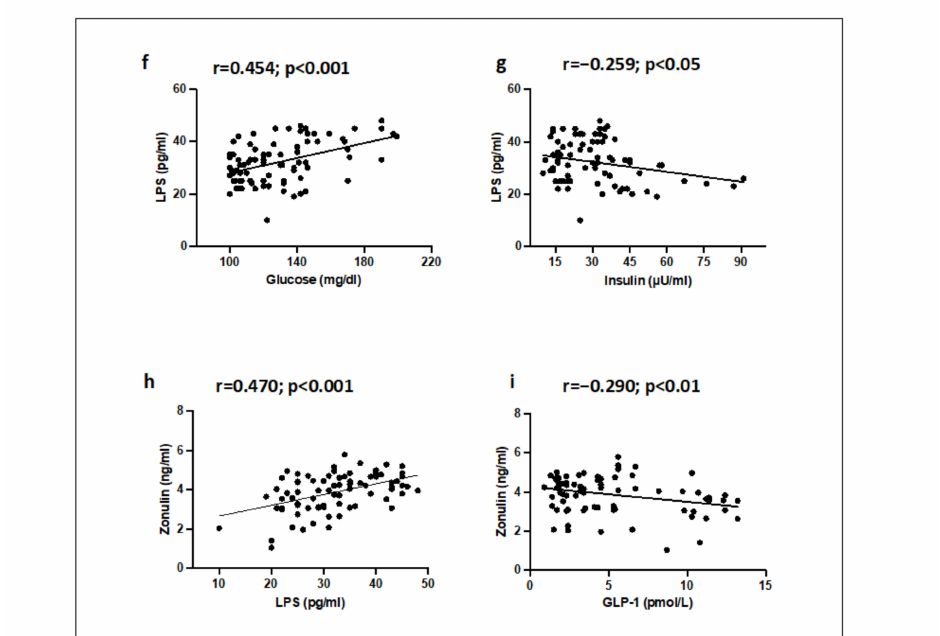
Figure 3. Serum levels of ( a ) glucose, ( b ) insulin, ( c ) GLP-1, ( d ) LPS, and ( e ) zonulin before (T0) and 2 h after (T2h) a meal with (black line) or without (grey line) extra-virgin olive oil (EVOO) in IFG patients ( n = 20). Correlations of circulating LPS levels with ( f ) glucose, ( g ) insulin, and ( h ) zonulin in IFG. Correlations of circulating Zonulin levels with ( i ) GLP-1 in IFG. ** p < 0.001, * p < 0.05. Similar modifications of metabolic profile, blood LPS, and zonulin as well as correlation analyses were observed in IFG patients ( n = 20) taking chocolate with EVOO added compared to controls (Figure 4a–i).